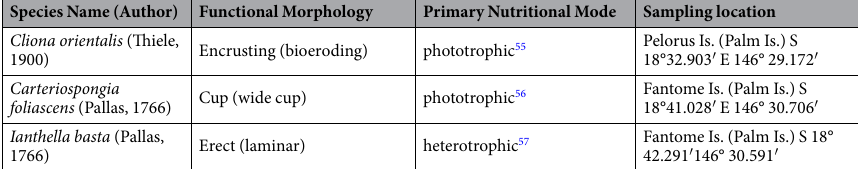
Table 5. List of sponge species, morphologies, nutrition mode and sampling